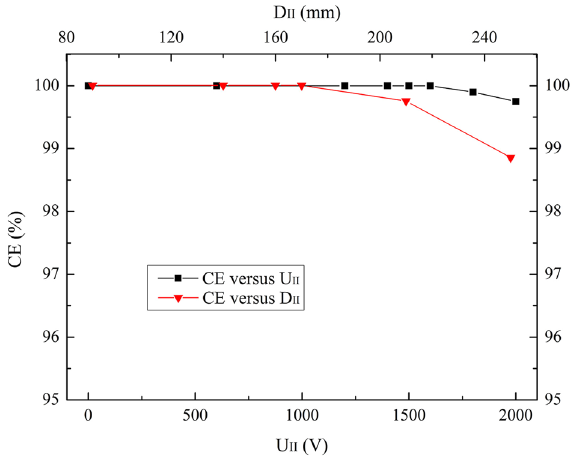
Figure 4. CE versus U II and D II over the ranges of 0 V ≤ U II ≤ 2000 V and 90 mm ≤ D II ≤ 250 mm.